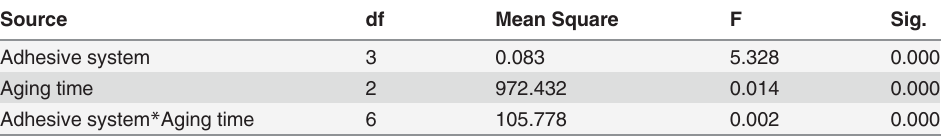
Table 7. Results of two-way (adhesives vs. time) analysis of variance (ANOVA) ( α = 0.05).